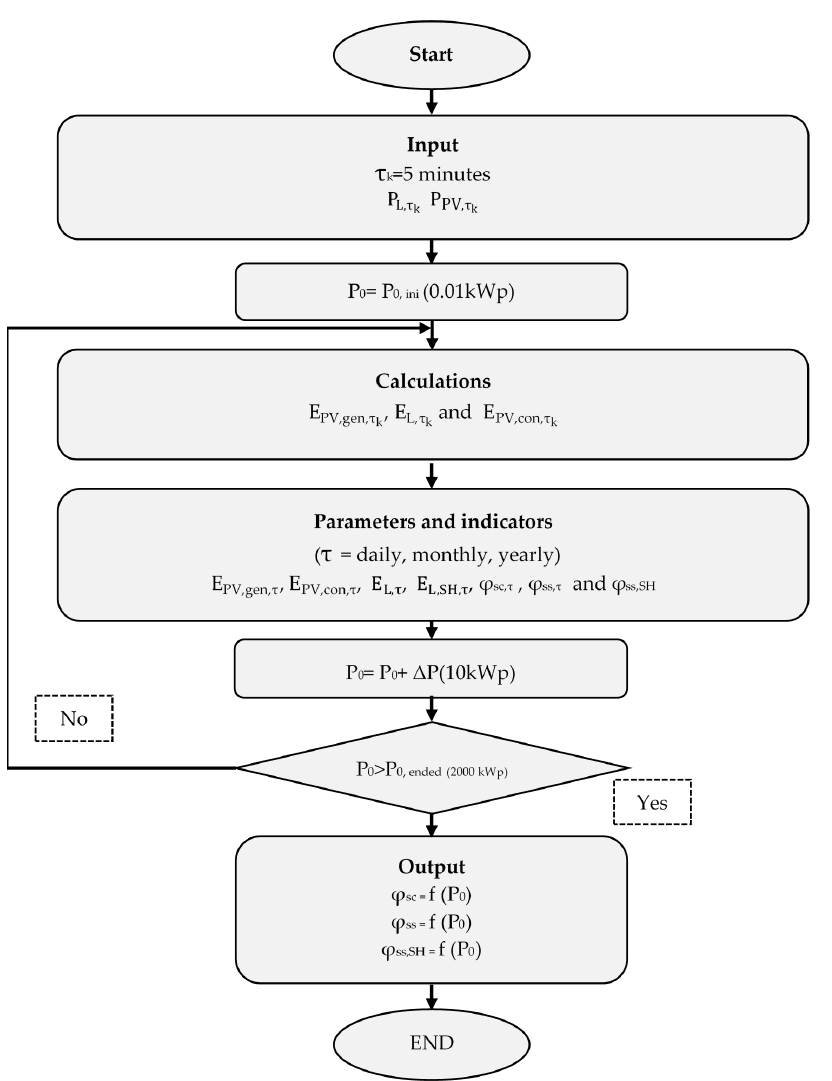
Figure 6. Method followed to estimate ϕ SC , ϕ SS and ϕ SS,SH , as a function of the nominal power of the array, P 0